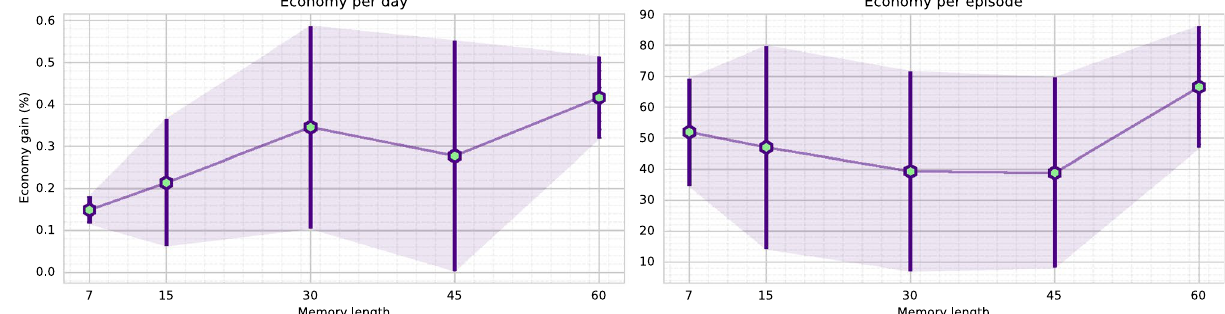
Figure 12. The graphs depict the economic benefits secured while the agent performed. The left graph presents an average economy gain per day, and the right illustrates the total economic gain per episode. The difference between average and total gain is due to the dynamic day of the environment. The environment is kept running until the disease fully mitigates. Therefore, agents that require a higher time to mitigate a disease gets higher time to make an economic profit.